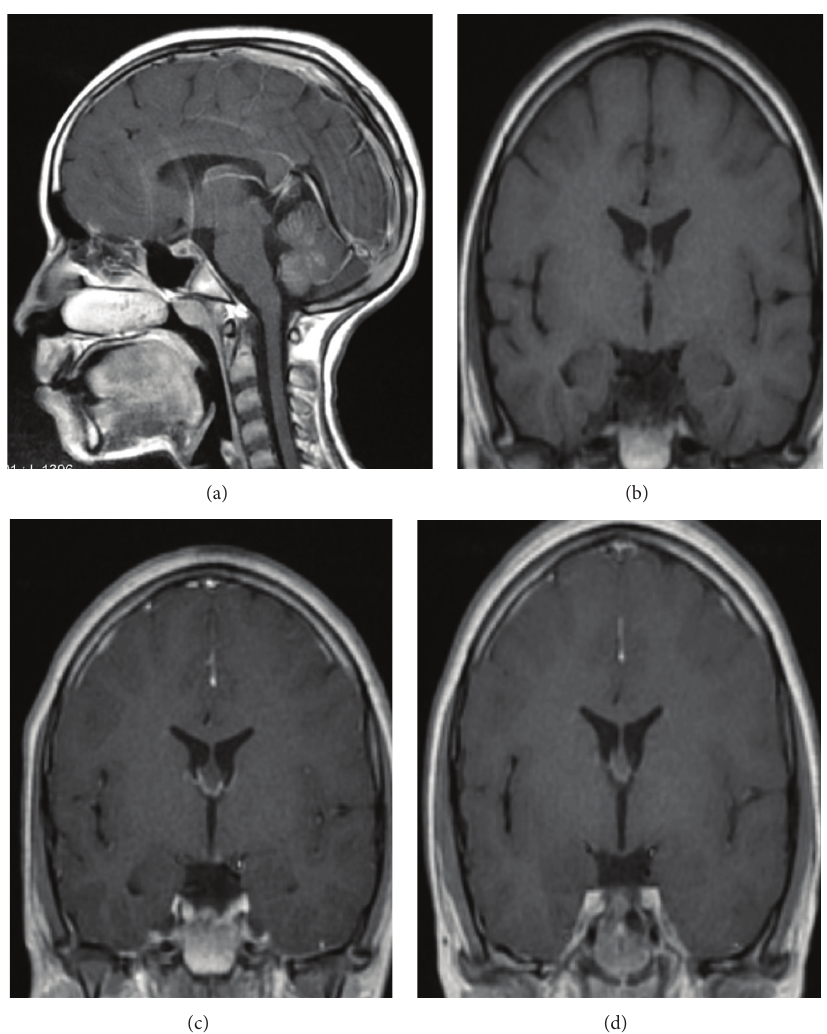
Figure 4: (a) Sagittal T1 with contrast image showed persistence of gadolinium in a follow-up study conducted 4 months later. (b)–(d) Sequential coronal T1 images showing the baseline mamillary body when MRI was performed during the first episode (b), enhancement of mamillary body during the second episode (c), and atrophy of mamillary body in a follow-up MRI performed 4 months later